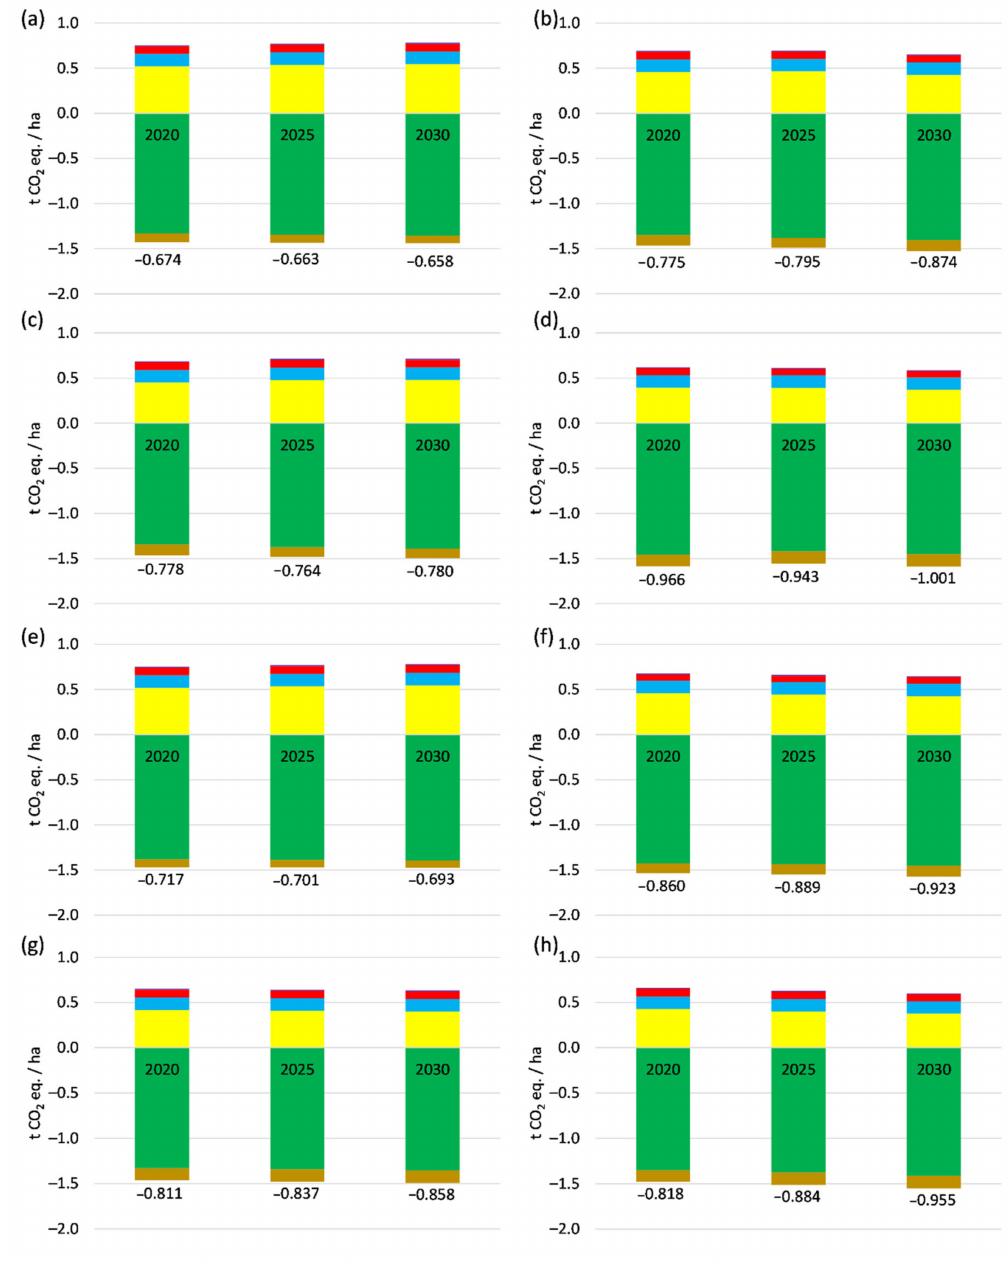
Figure 6. Predicted carbon emission and absorption from the land use, land use change and forestry (LULUCF) sector in Lithuania, depending on scenario: ( a ) Reference (2005–2010), ( b ) Reference (2010–2015), ( c ) producing land to forest (2005–2010), ( d ) producing land to forest (2010–2015), ( e ) grassland to forest (2005–2010), ( f ) grassland to forest (2010–2015), ( g ) no grassland to producing land (2005–2010), and ( h ) no grassland to producing land (2010–2015). The value shown below each bar indicates the total carbon sequestration value. Numeric values can be found in Appendix A, Table